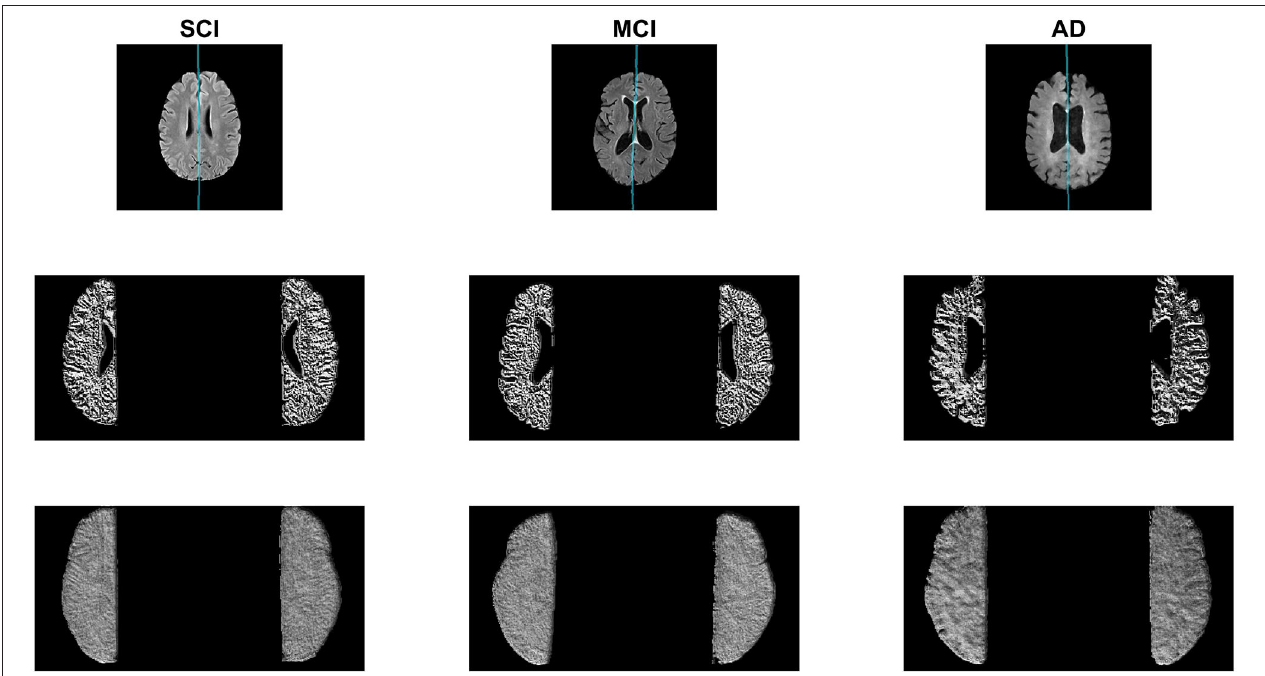
FIGURE 9 | Sample AD, MCI, and SCI slice (Top) with corresponding LBP slice (Middle) and LBP pixel-wise average (Bottom)